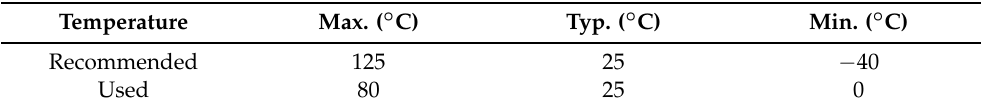
Table 2. Values of the circuit temperature recommended by the manufacturer and those used for the